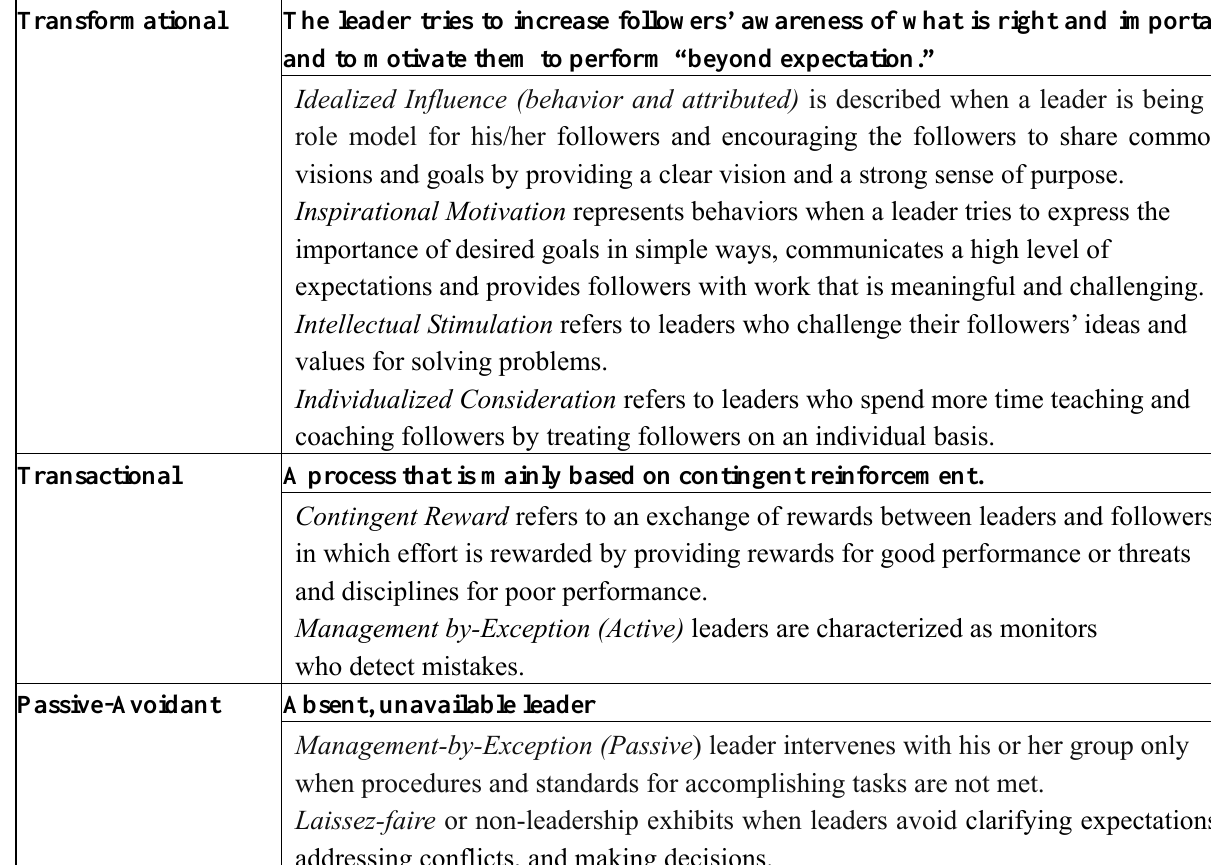
Table 2. Multifactor Leadership Questionnaire (MLQ)